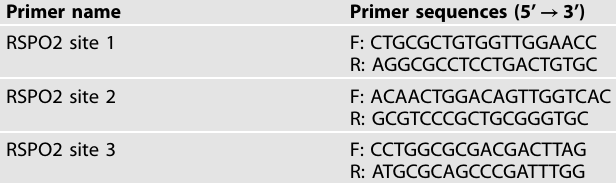
Table 5. Primers used for